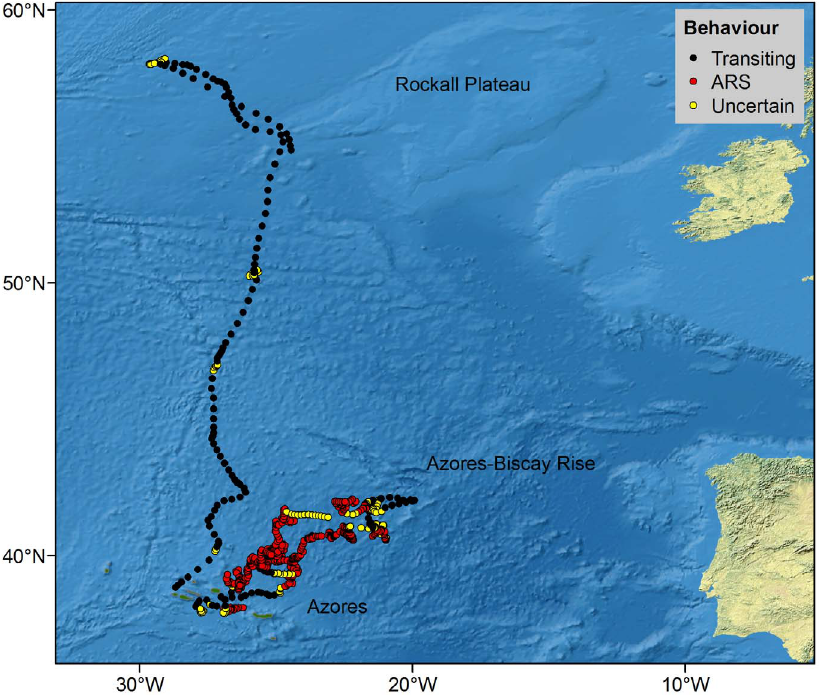
Figure 7. Hierarchical switching state-space model derived locations of blue whales showing inferred behavioural modes.